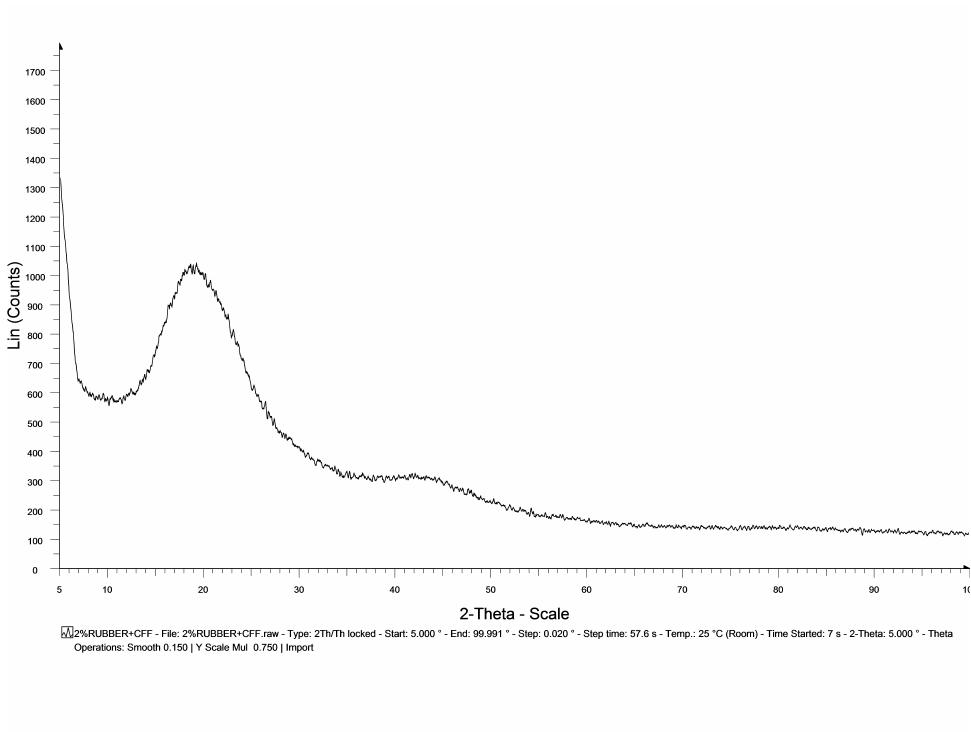
Figure 27: XRD for neat epoxy resin.